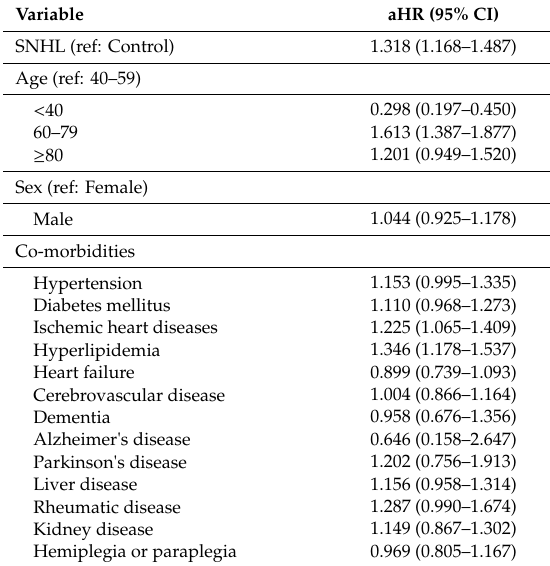
Table 3. Multiple Cox proportional hazard regression for estimation of adjusted hazard ratios on